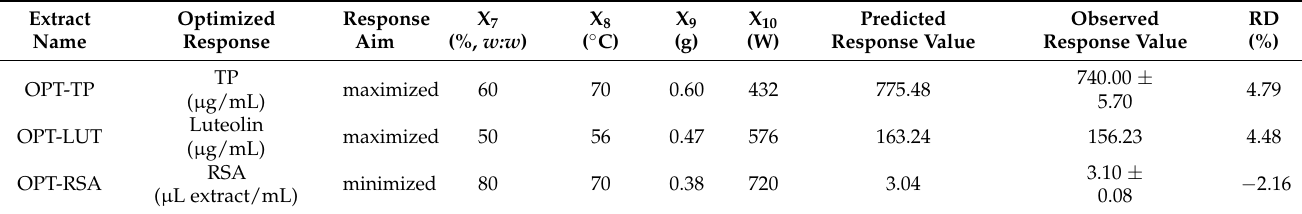
Table 3. Predicted and observed response values for the extracts prepared at optimal